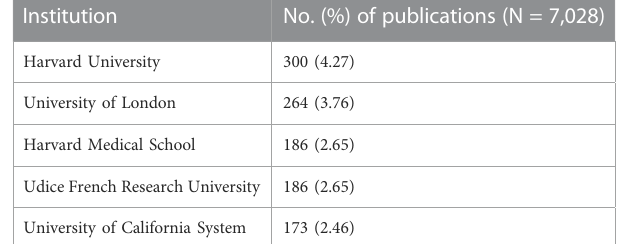
TABLE 3 The top fi ve countries. Country